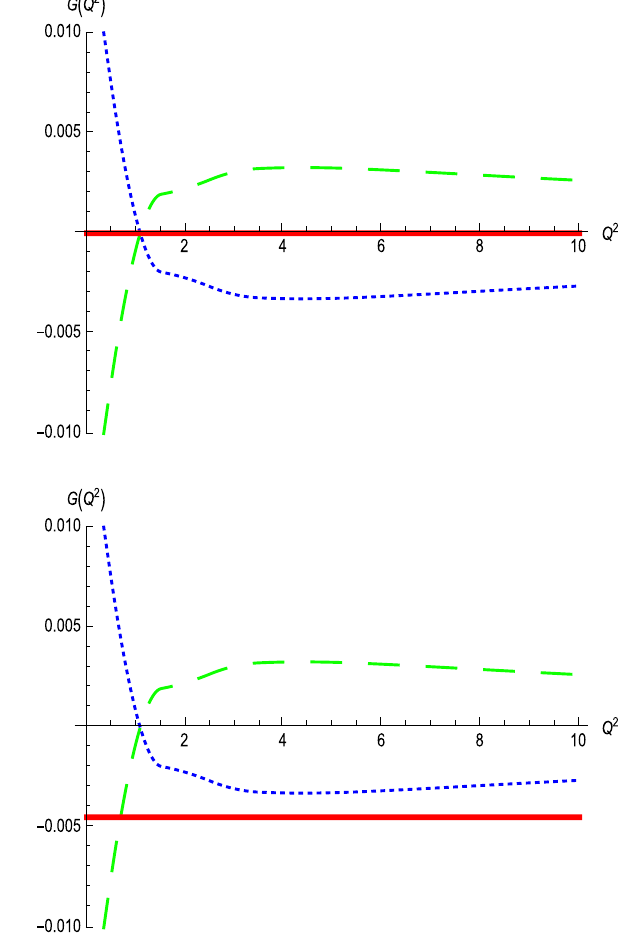
Fig. 20 Contributions to the 2 → 3 transition form factor G ( Q 2 ) : the dashed line is G 10 ( Q 2 ) and the dotted line G 00 ( Q 2 ) . The sum of them (solid line) is the full form factor G ( Q 2 ) (upper panel): it is of the order of 10 − 6 and results from contributions of several orders of magnitude greater. A small error in computing the binding energy, e.g., B i = 3 . 512 · 10 − 3 instead of B i = 3 . 51169 · 10 − 3 and B f = 0 . 2084 instead of B f = 0 . 2084099, would provide G ( Q 2 ) ≈ − 0 . 005